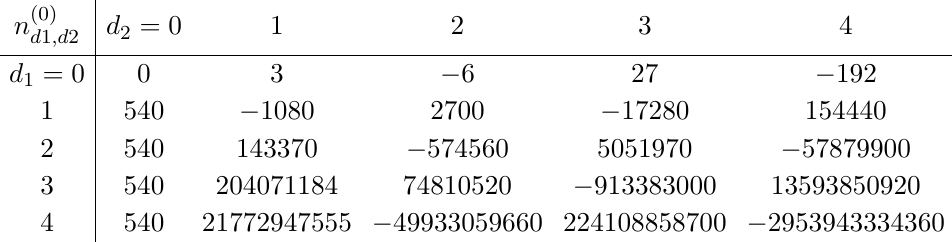
Table 5 . Genus zero Gopakumar-Vafa invariants that arise from the elliptic fibration with toric data (6.1) in the limit m → 0 . This corresponds to q parametrization